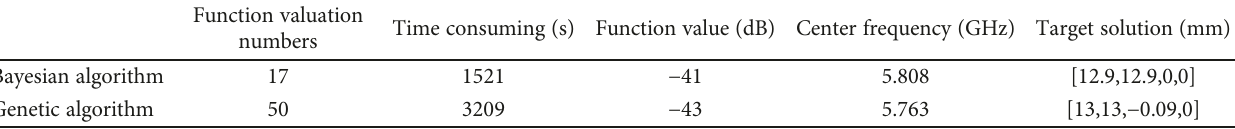
Table 3: Comparison of the antenna element optimization results.